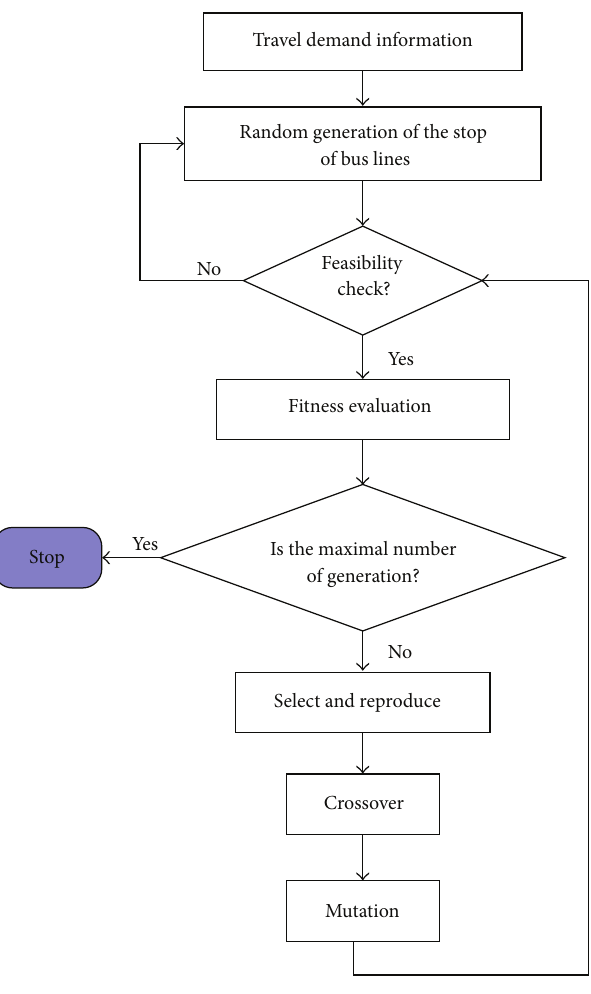
Figure 2: Overall procedure for finding an optimal